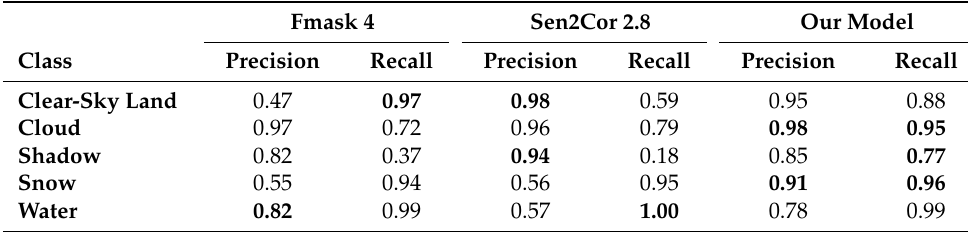
Table 8. Comparison of precision and recall with Fmask 4 and Sen2Cor 2.8.